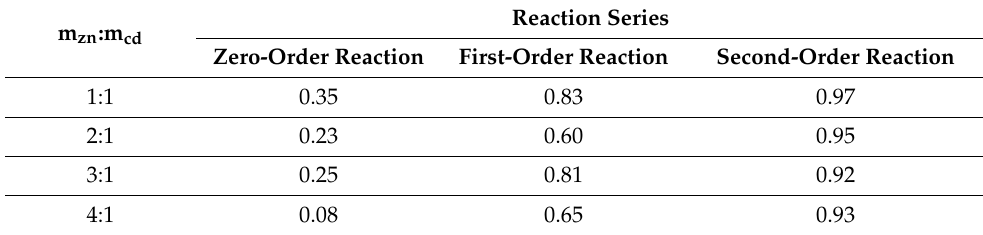
Table 5. Summary of the fitting degree of each